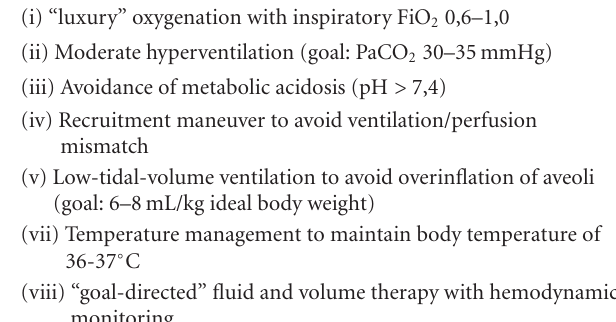
between the aorta and the right ventricle, which, in the setting of increased RV afterload and decreased coronary blood flow, may lead to RV ischemia [59].